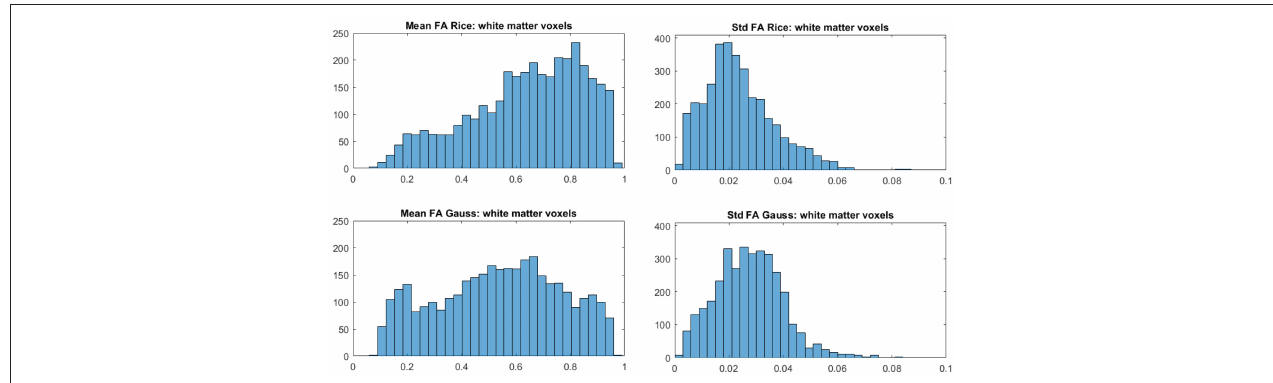
FIGURE 5 | Histograms of posterior means (left) and posterior standard deviations (right) of FA for white-matter voxels for the Rician and Gaussian DTI models, using the whole dataset. A white-matter voxel is defined as a voxel where the probability is 1 for white matter from the function FAST in FSL.